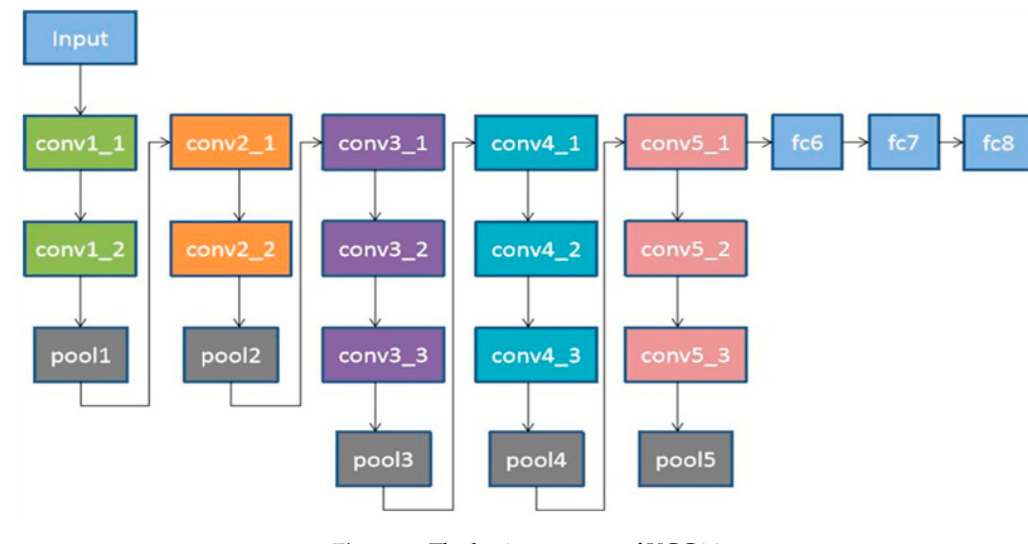
Figure 4. The basic structure of